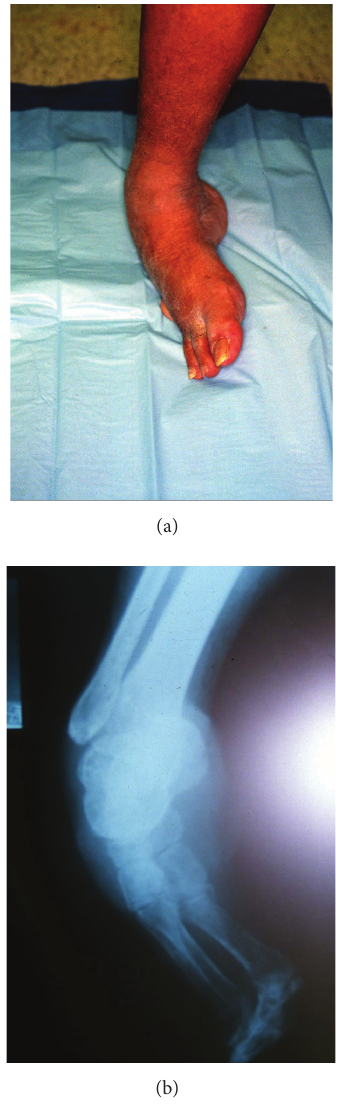
F 5: (a) Overpowering of the extrinsic foot muscles leading to an equinus deformity at the ankle and a varus hindfoot. (b) X-ray image showing ankle and foot